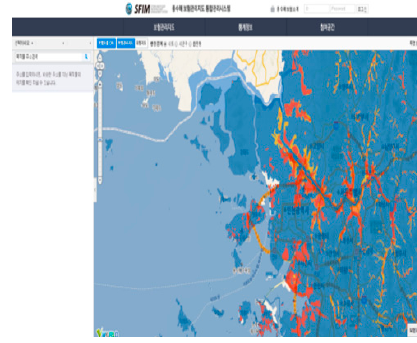
Figure 10. Web-based storm and flood insurance management system, NOAA Figure 9. Spatial data upload process.